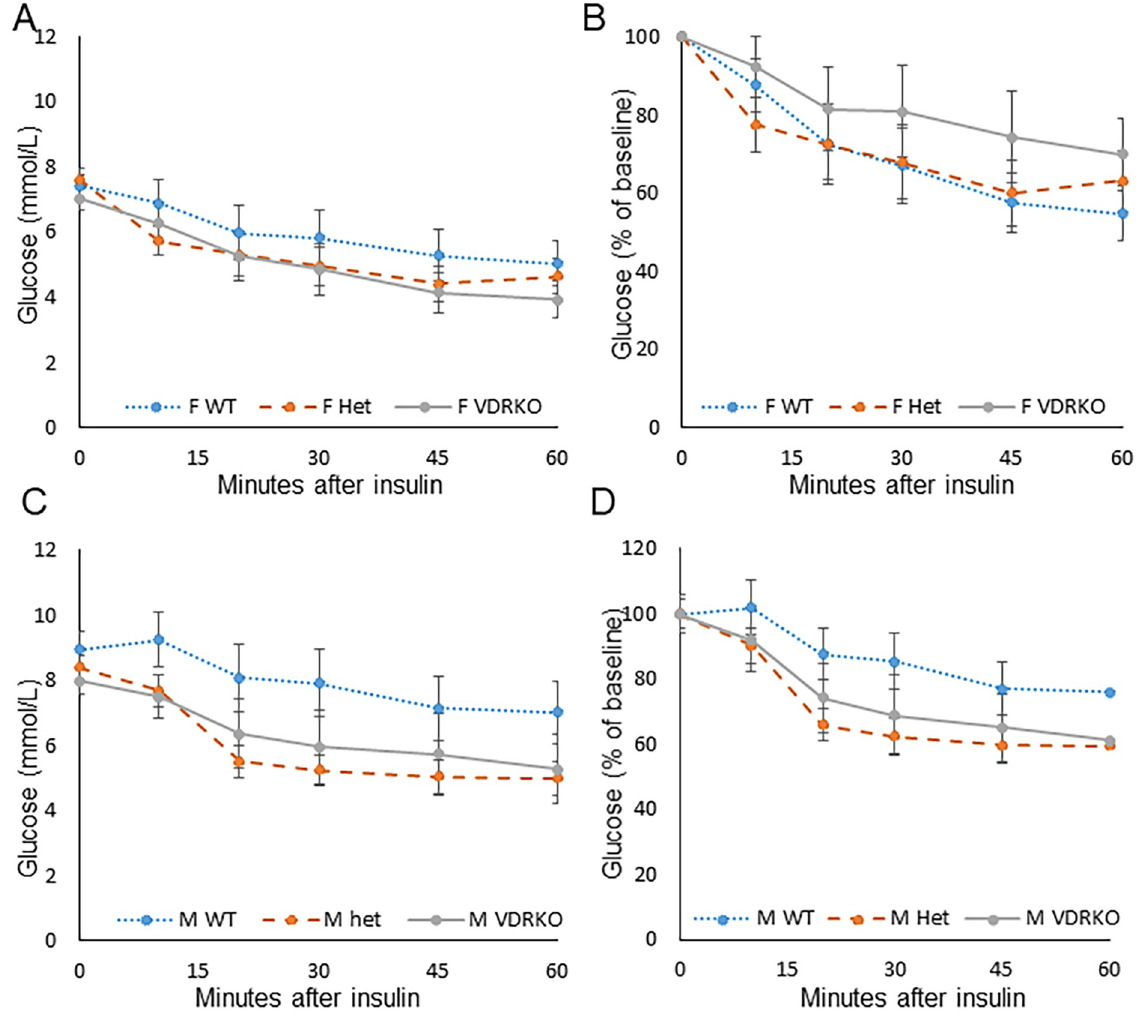
Fig 2. Insulin sensitivity at 25–26 weeks, assessed by glucose response to insulin. A) Female glucose levels after insulin administration. B) Female results as % of baseline glucose for the individual mouse. C) Male glucose results after insulin injection. D) Male results as % of baseline glucose values. Data shows mean ± SEM. All mice were fed rescue diet. N � 14 mice per group.